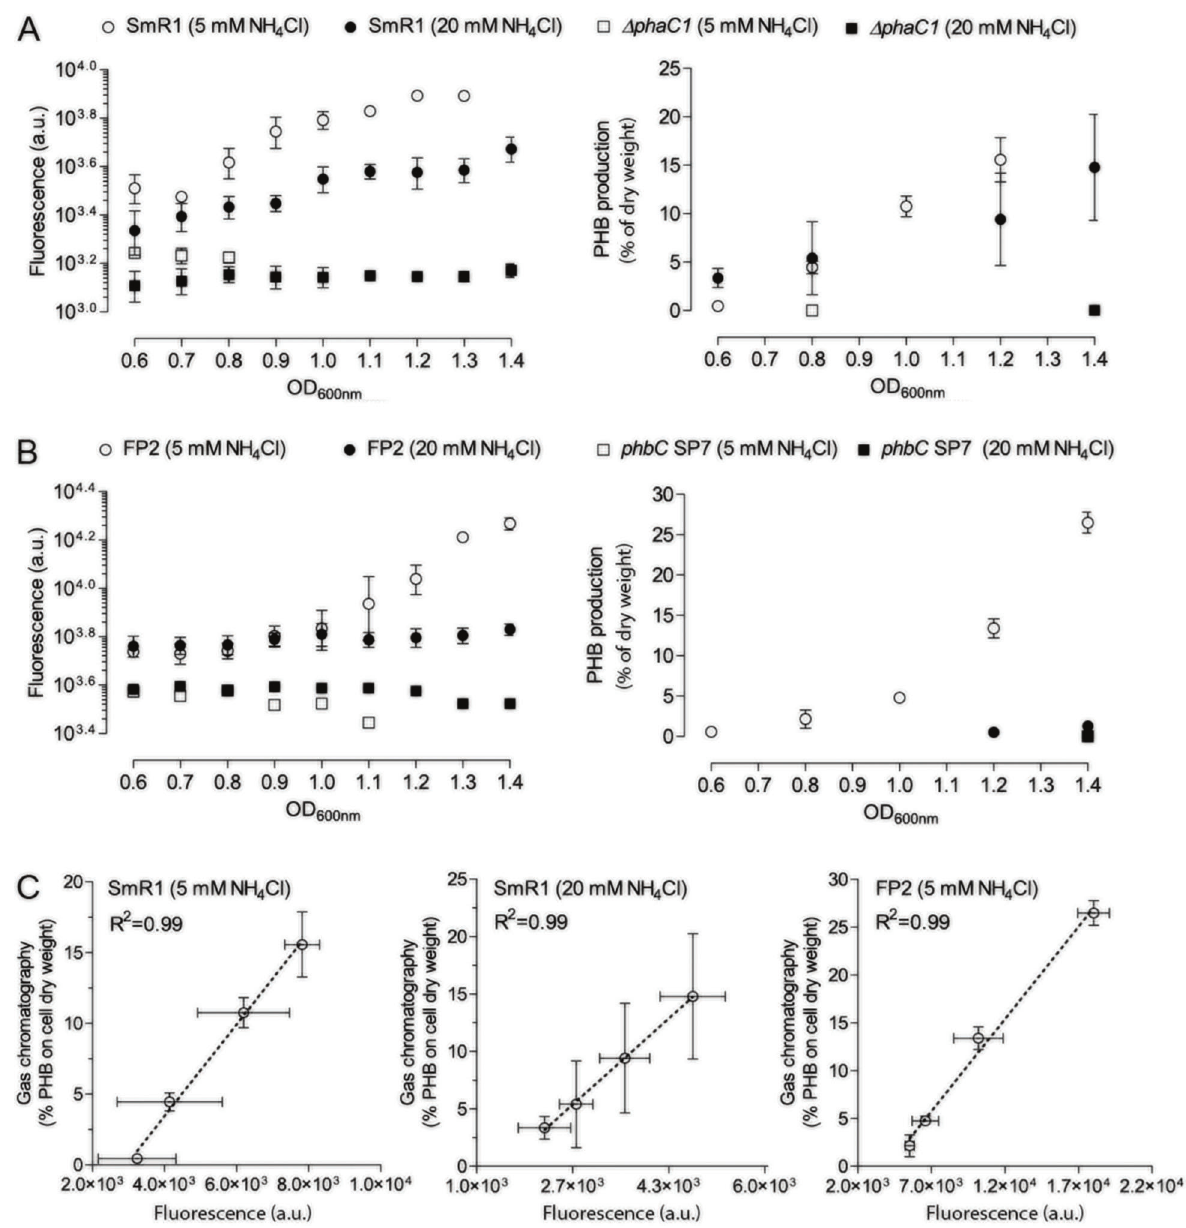
Figure 5. Correlation between fl ow cytometry and gas chromatography (GC) analysis for PHB quanti fi cation. PHB measurements by fl ow cytometry using the optimized procedure and the standard method based on GC were applied on H. seropedicae strain SmR1, a mutant strain of H. seropedicae , D phaC1 , A. brasilense strain FP2, and a mutant strain of A. brasilense , phbC SP7, OD 600 ranging from 0.6 to 1.4 using two NH 4 Cl concentrations in growth medium, as indicated. A , H. seropedicae . B , A. brasilense . C , Correlation between fl ow cytometry and GC. Fluorescence data (arbitrary units, a.u.) are reported as means ± SD of 3 independent experiments with H. seropedicae strain SmR1 and A. brasilense strain FP2, by using the median fl uorescence intensity values in the FL2-H